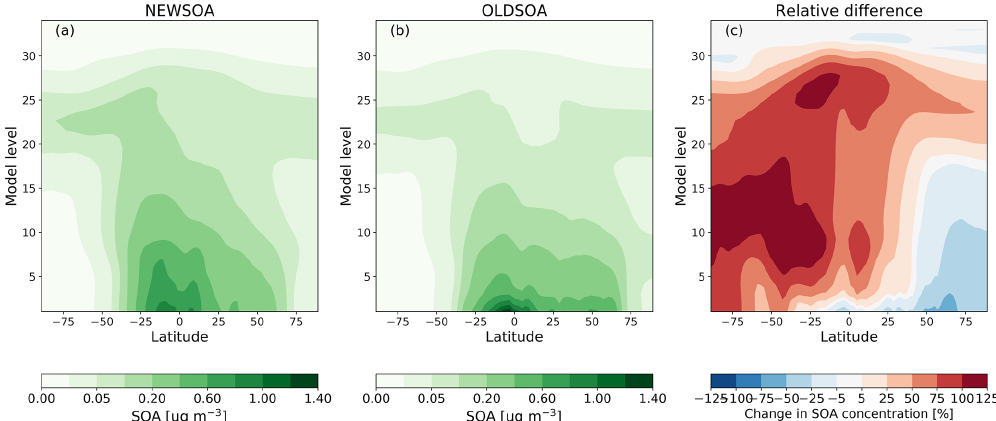
Figure 6. Zonal annual mean concentration of SOA in simulations NEWSOA (a) and OLDSOA (b) , as well as the relative change from OLDSOA to NEWSOA (c)